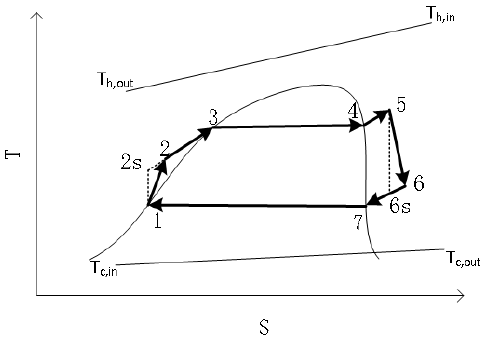
Figure 2. Temperature entropy diagram of the ORC power generation system.